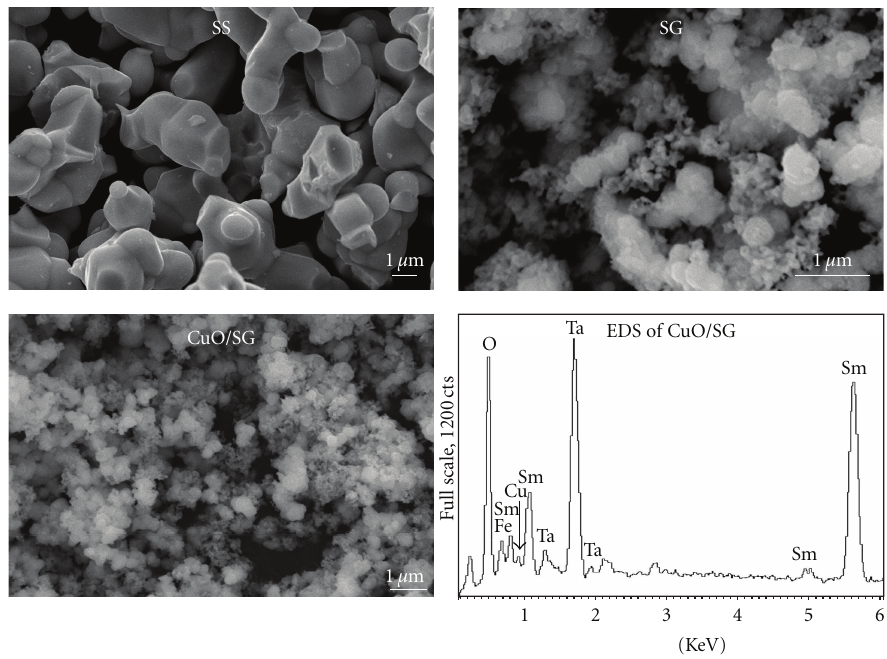
Figure 2: SEM images for Sm 2 FeTaO 7 synthesized by solid state and sol gel.